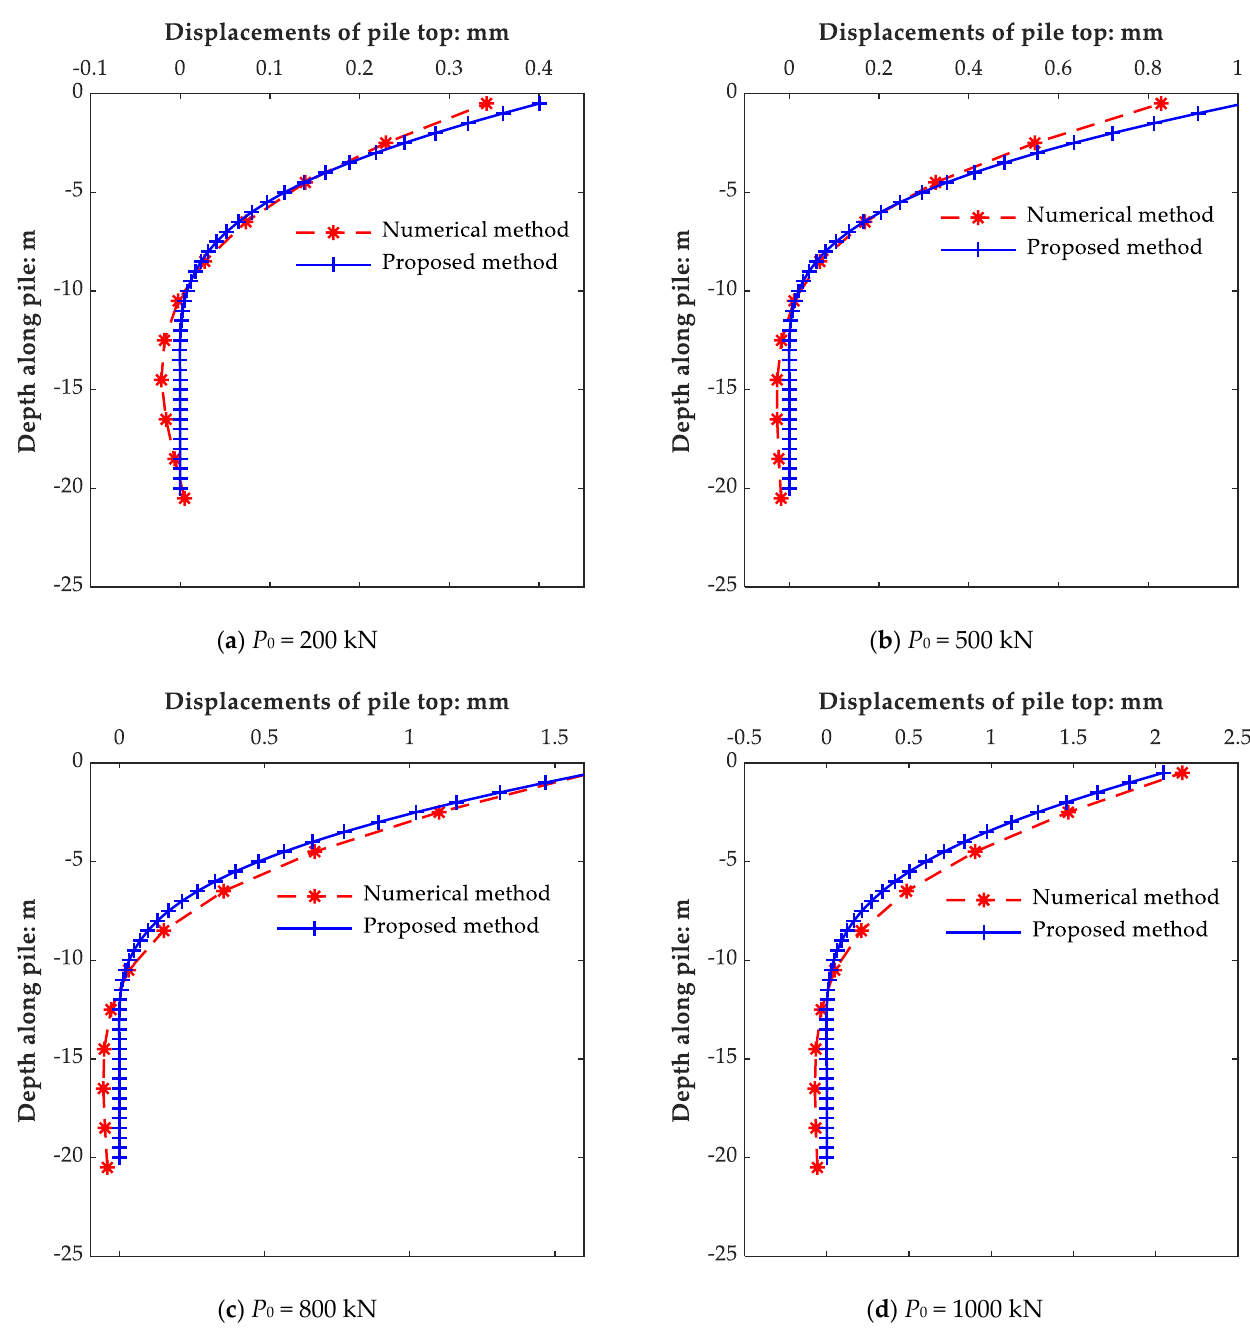
Figure 14. Distribution of pile displacement at various depths.